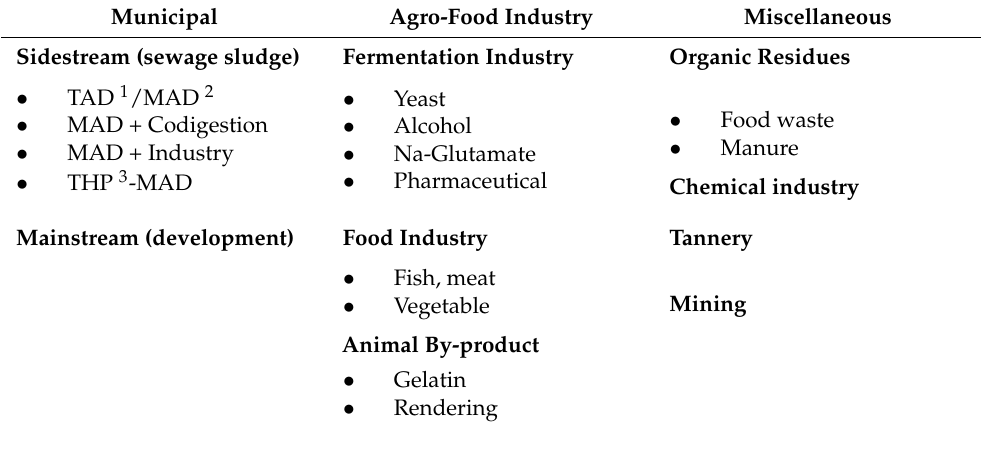
Figure 2. Historical development of the number and installed capacity of ANAMMOX plants (status June 2021) since the first full scale reactor at Sluisjesdijk in Rotterdam in 2002. Table 1. Market sectors in which ANAMMOX reactors have been applied.